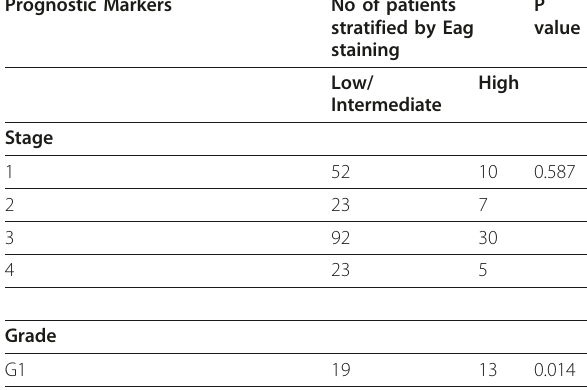
Table 2 Median survival based on Eag and HERG Table 3 Distribution of prognostic markers for ovarian immunoreactivity and other prognostic markers cancer stratified by Eag staining (Fisher ’ s exact test) Median survival, Prognostic Markers No of patients Months(IQR) stratified by